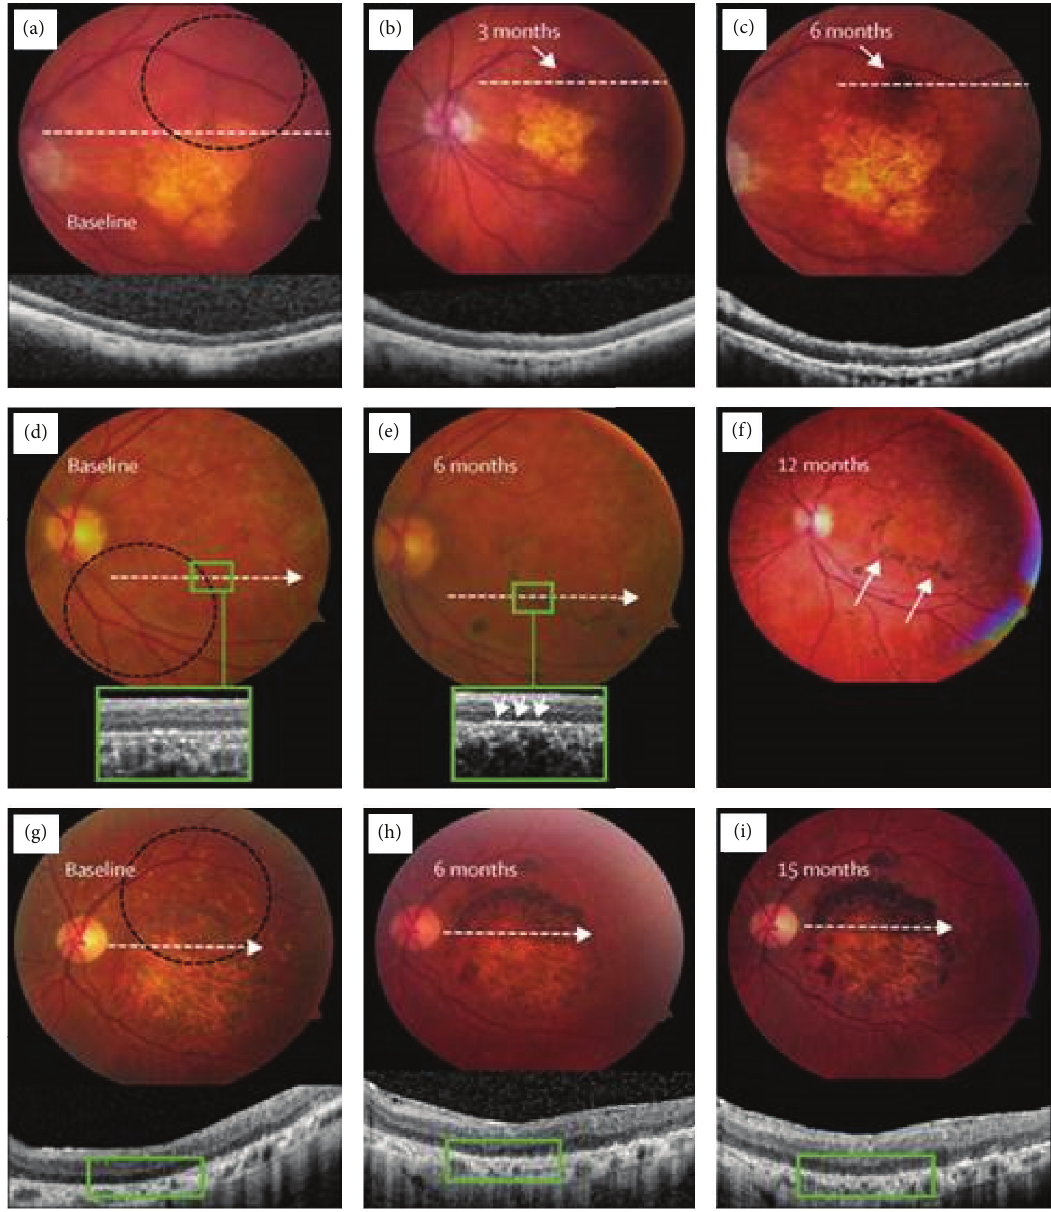
Figure 7: Pictures of eye fundus with pigmentation where retinal pigment epithelium differentiated from human ESCs was transplanted. (a–c) Color fundus pictures and images of spectral domain-optical coherence tomography at baseline of patient eyes of ARMD (dotted circle indicates an outline of the site of cell transplantation) and at an eye after 3 and 6 months of the transplantation. A pigmented patch of transplanted cells (arrows in (b) and (c)) grows bigger and has more pigmentation in six months. Optical coherence tomography (inset of figures) indicates the existence of cells on the inner sites of Bruch’s membrane at six months compared with the baseline of the eye. (d–f) Color fundus pictures and pictures of spectral domain-optical coherence tomography at baseline of patient eyes of Stargardt’s macular dystrophy (dotted circle indicates an outline of the site of cell transplantation) and an eye after six and twelve months after transplantation. Patches of transplanted cells exist around the edge of baseline atrophy in retinal pigment epithelium (e), which grow more significant after twelve months (arrows in (f)). Pictures of spectral domain-optical coherence tomography at baseline (d) and six months (e) indicate that the enhancement of pigmentation is found at the level of normal monolayer retinal pigment epithelium engraftment, the retinal pigment epithelium, and survival at six months (arrows in (e)), which is close to the site of bare Bruch’s membrane being lack of native retinal pigment epithelium. (g–i) Color fundus pictures of a patient of Stargardt’s macular dystrophy (dotted circle indicates an outline of the transplantation site). A big central site of atrophy can be seen on the preoperative picture (g). A site of transplantation of retinal pigment epithelium cells can be seen at the superior half of the atrophic lesion at six months (h), which grows bigger and has more pigmentation at fifteen months (i). Copyright 2015. Modified with permission from Elsevier Ltd.